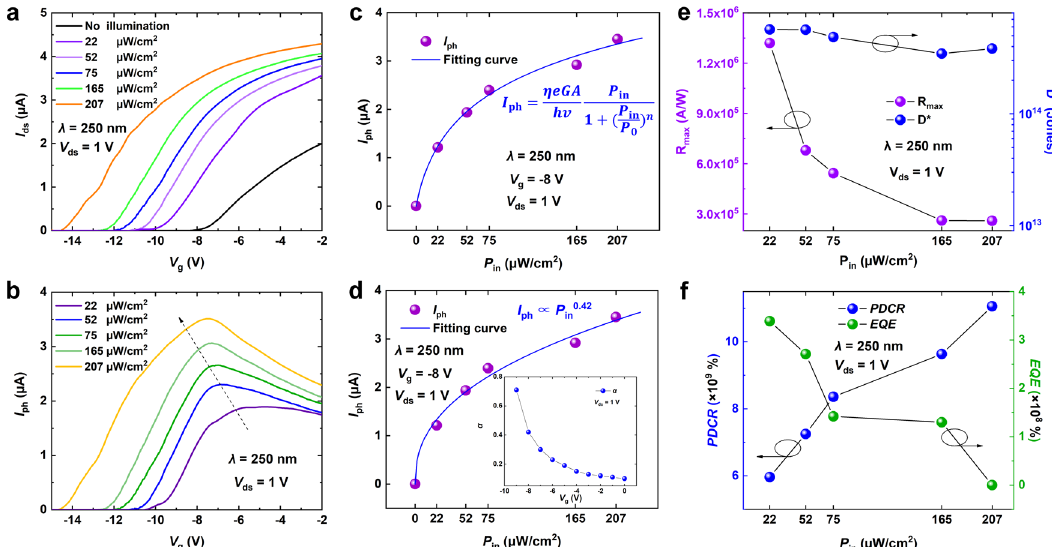
Fig. 3 The photoelectrical properties of the fabricated β -Ga 2 O 3 phototransistor. At 250 nm excitation wavelength . a Transfer characteristic of the device under the dark and different illumination power intensities ( P in ) conditions at V ds = 1 V. b Dependence of I ph on V g under different illumination P in at V ds = 1 V. c The P in dependence of I ph curve at a fi xed gate voltage of − 8 V and V ds = 1 V. d The I ph as a function of P in at V g = − 8 V and V ds = 1 V. Inset: α as a function of V g . e The corresponding R max and D * dependence of P in . f PDCR and EQE values versus P in at V ds = 1